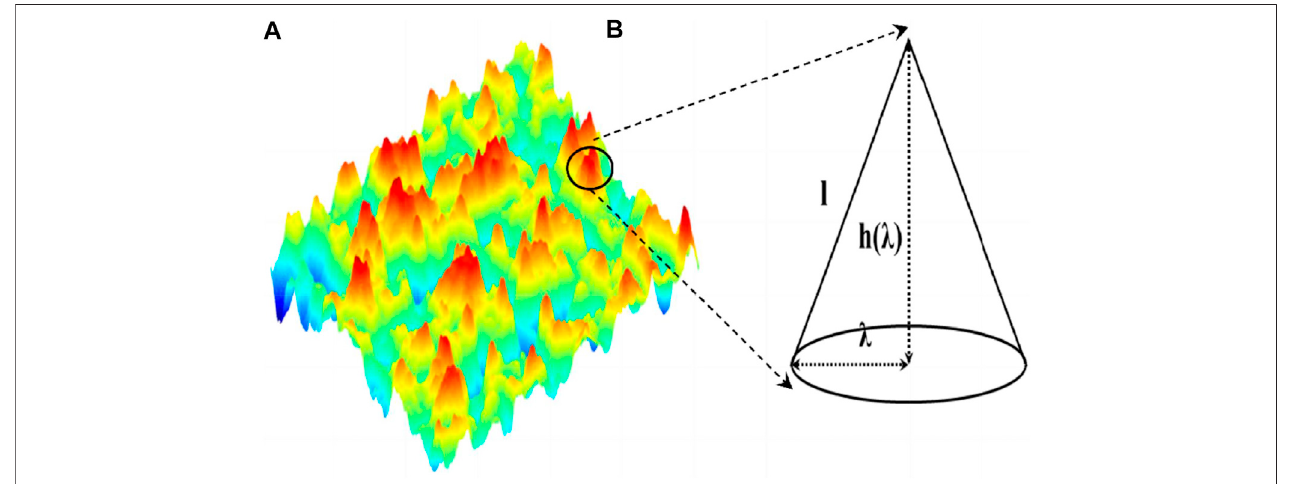
FIGURE 1 | Schematic illustrations of the rough surface. (A) A real surface with random character; (B) A representative cone-like rough element.